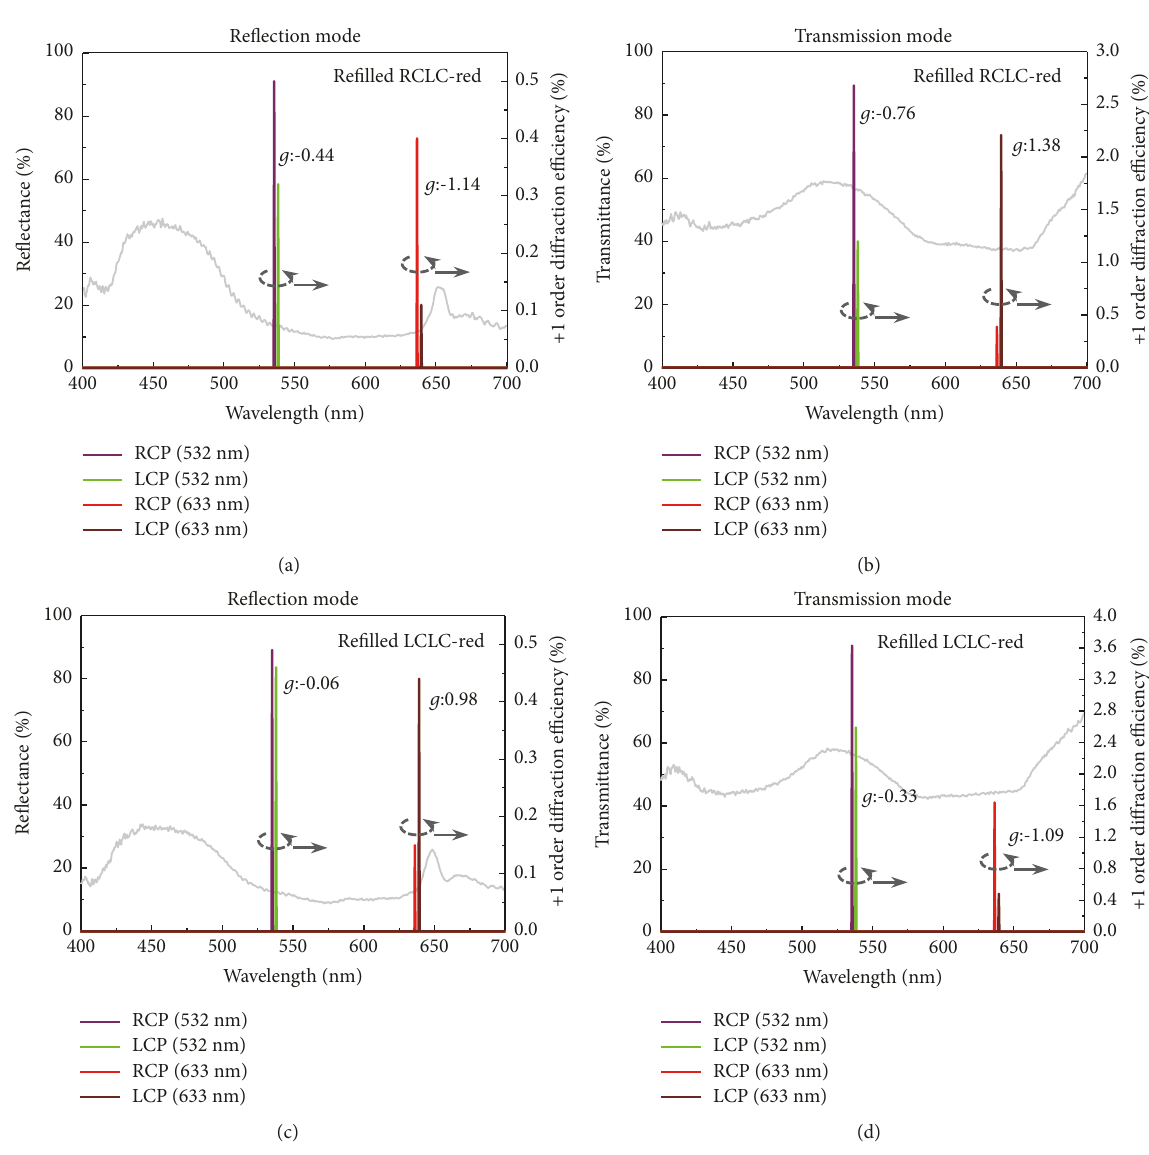
Figure 2: Measured +1 order diffraction efficiencies of the refilled CLC template grating in (a)/(c) reflection mode and (b)/(d) transmission mode by the RCP and LCP lights with the wavelengths of 532 and 632 nm, respectively. The refilled material is RCLC-red in (a)/(b) and LCLC-red in